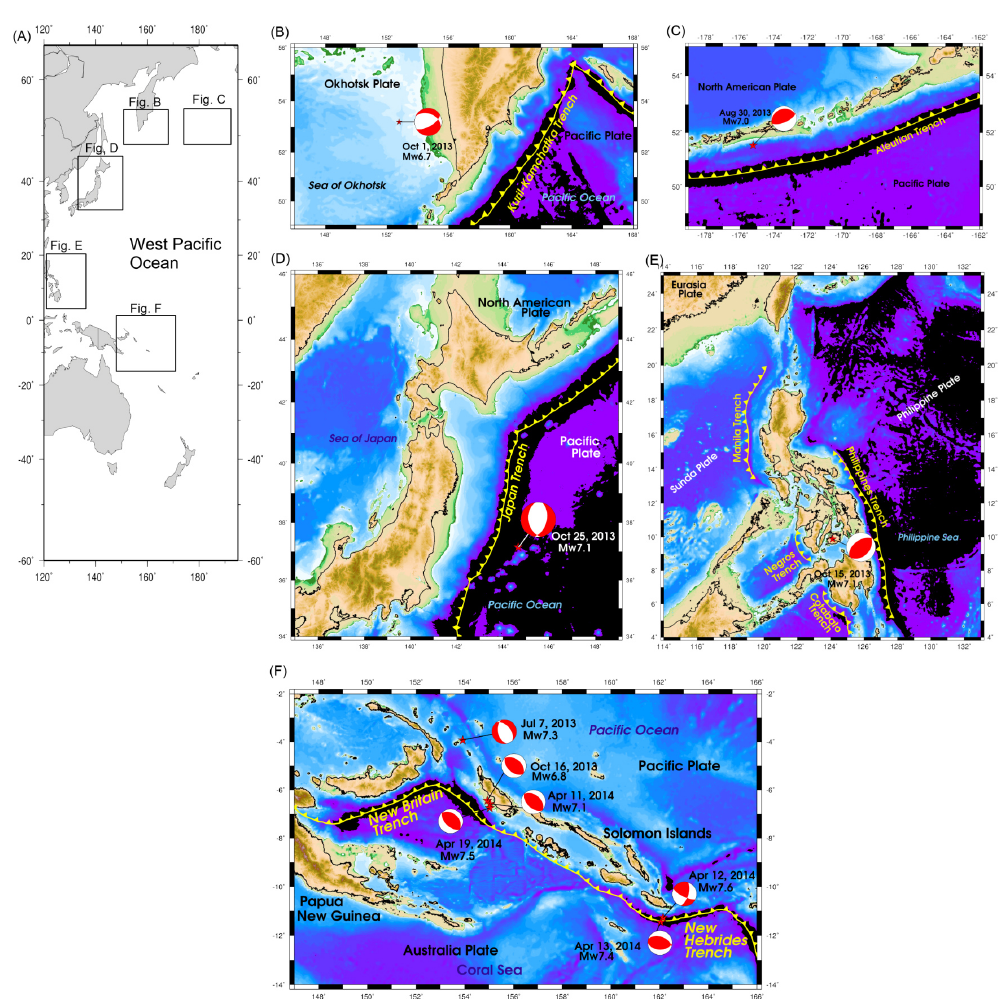
Figure 2. Earthquake events which occurred in the west Pacific source zone: (a) overview of the source zone; location of the epicenters (red stars), focal mechanisms (red beach balls), and subduction zones (yellow lines) for: (b) the Okhotsk-Russia normal faulting event, (c) the Alaska thrust fault event, (d) the Honshu normal faulting event, (e) the Philippine reverse faulting event, and (f) six events, four around the Papua New Guinea, their focal mechanisms: three are normal faulting and one is thrust faulting, and two near the Solomon Island, their focal mechanisms: a strike–slip and a reverse